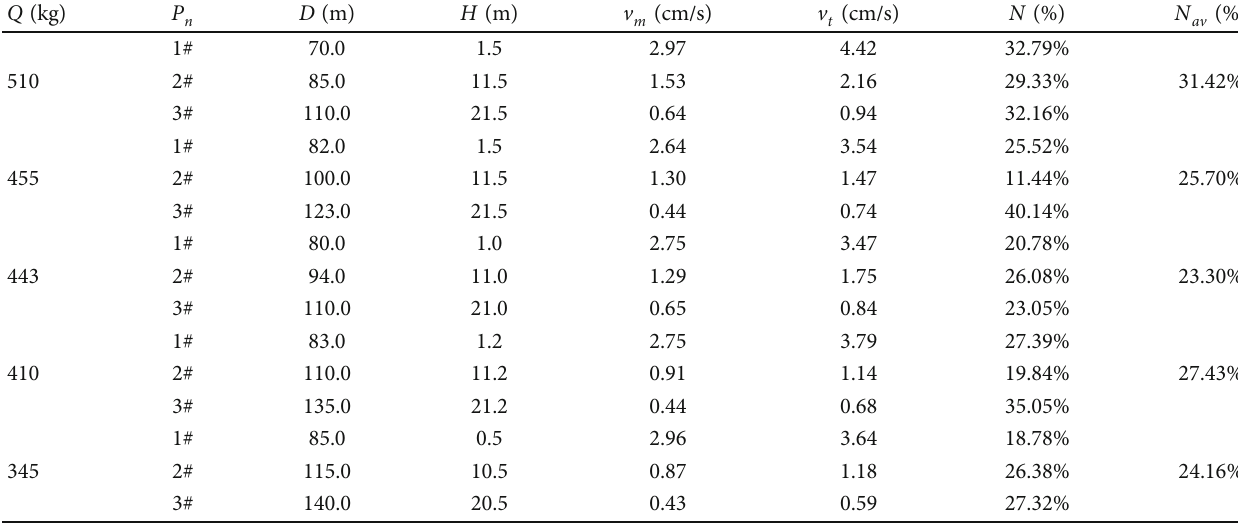
Table 5: Comparative analysis of blasting vibration by presplit holes simultaneous detonated.